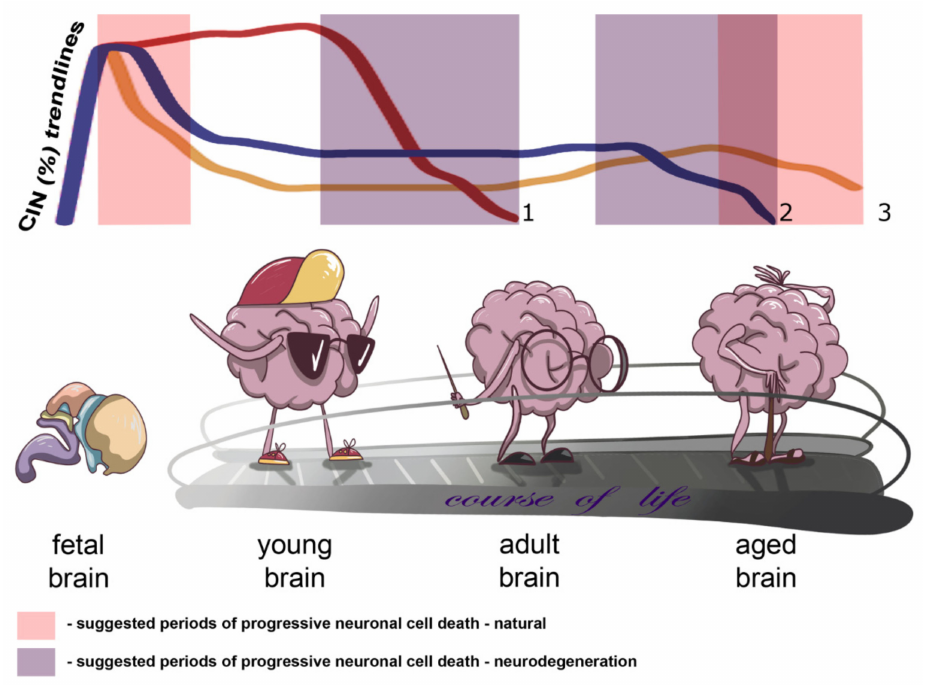
Figure 1. Schematic depiction of changes in chromosome instability CIN rates in the context of brain aging and neurodegen- eration indicating trends of brain-specific CIN rates through ontogeny and/or the course of life and suggested periods of progressive neuronal cell death in health and disease (natural and neurodegeneration, respectively): 1 or reddish trendline— CIN trend for early onset neurodegenerative diseases with accelerated aging phenotypes, e.g., ataxia-telangiectasia; 2 or blueish trendline—CIN trend for late onset neurodegenerative diseases; 3 or yellowish trendline—natural CIN